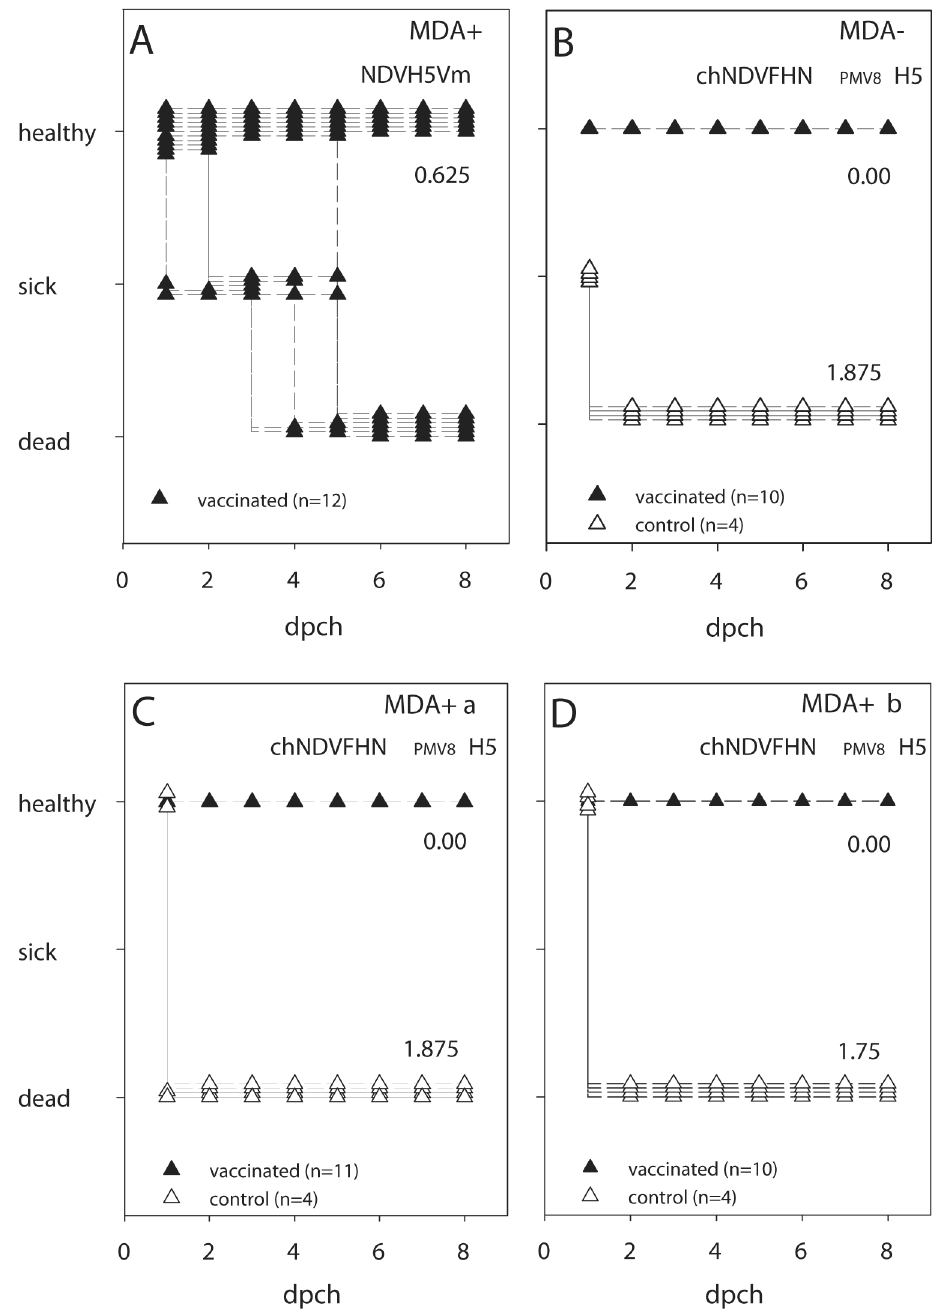
Figure 5. Clinical course after HPAIV H5N1 challenge infection. MDA+ chickens which were vaccinated with NDVH5Vm (A), and MDA- (B) as well as MDA+ birds (group a vaccinated on day 1 after hatch (C), group b vaccinated on day 7 after hatch (D)) which were vaccinated with chNDVFHN H5, and naive controls were challenged at day 21 after vaccination with A/duck/ PMV8 Vietnam/TG24-01/05 and daily classified as healthy (0), sick (1), or dead (2) over a period of 8 days. The average scores of all animals of each group are indicated. doi: